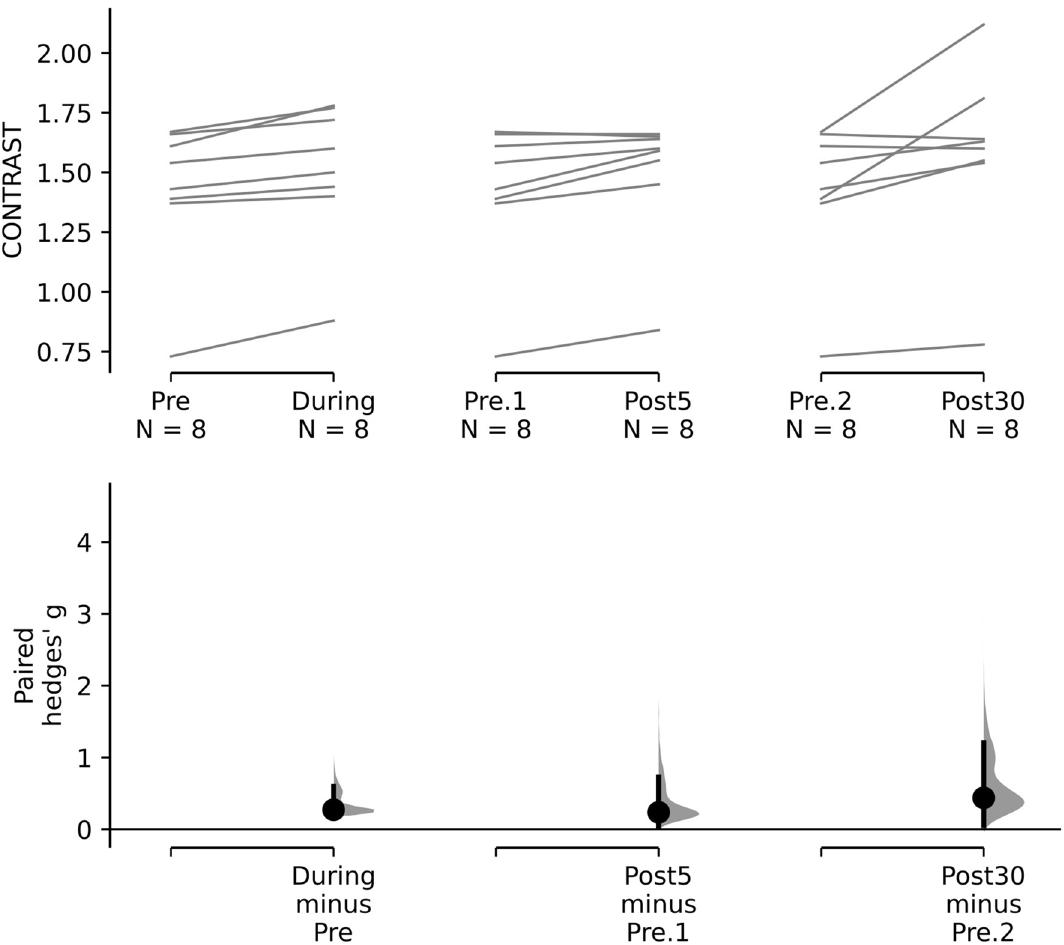
Figure 4. Paired Hedges’ g for three comparisons (during stimulation, Post 5 min, Post 30 min) to pre-test contrast sensitivity are shown for the active group amblyopic eye contrast sensitivity data using a Cumming estimation plot. Raw contrast threshold data for each participant are plotted on the upper axes; each paired set of observations is connected by a line. On the lower axes, paired Hedges’s g is plotted as a bootstrap sampling distribution. Hedge’s g value is depicted as dots; 95% confidence intervals are indicated by the ends of the vertical error